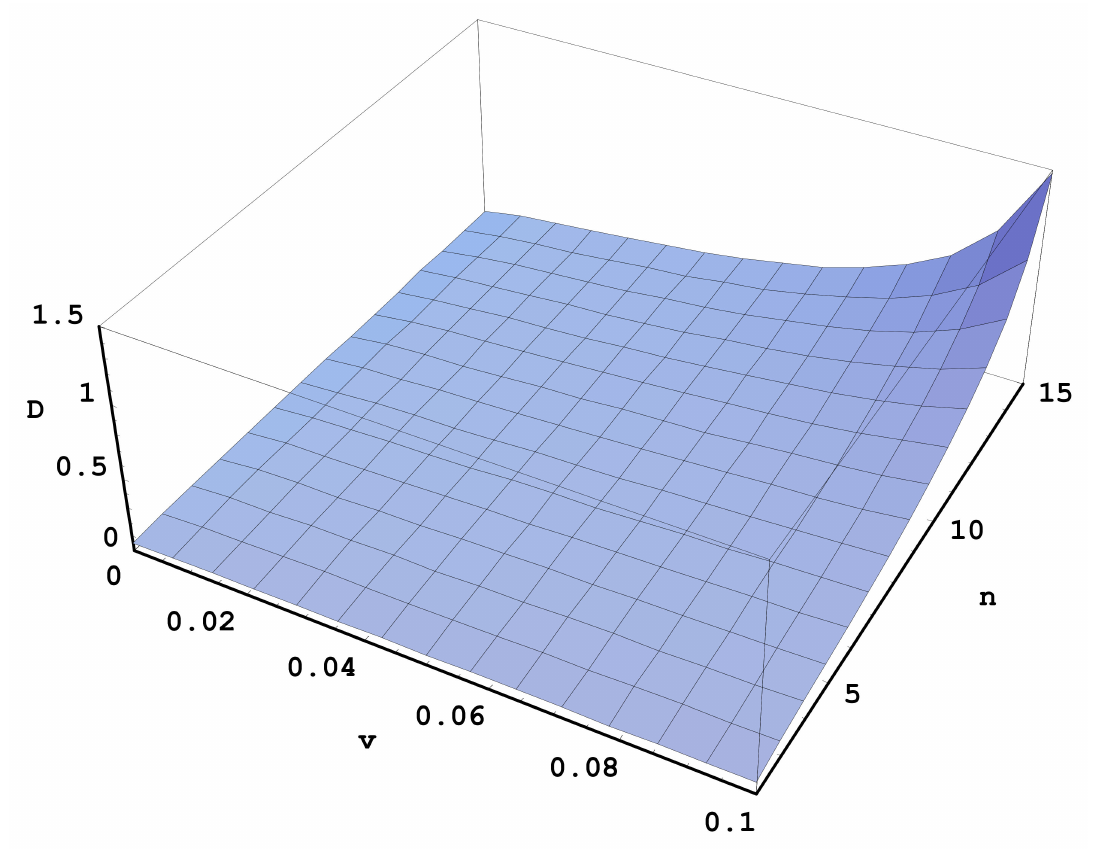
Figure 1. The relative difference in the cross-sections D = ( σ − σ 2 )/ σ 2 vs. the relative velocity v of the colliding particles and the principal quantum number n for the quantum number q = n − 1. The values of σ and σ 2 are given by Equations (8) and (9),